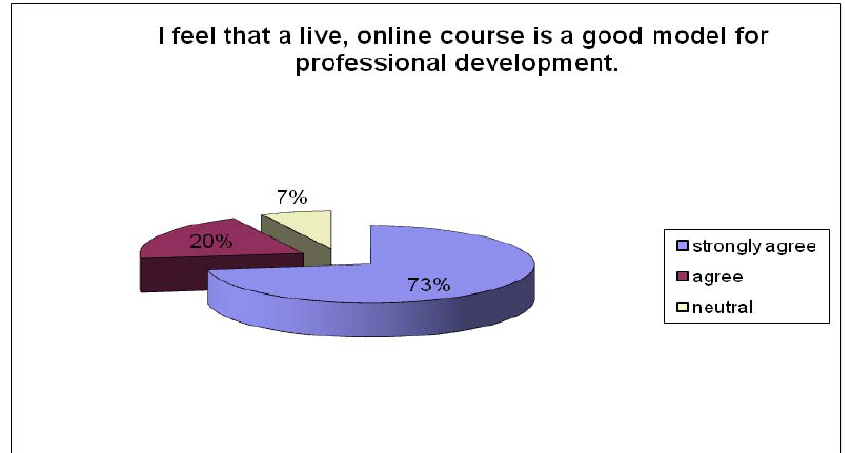
Figure 3. Short-courses as a good model for professional